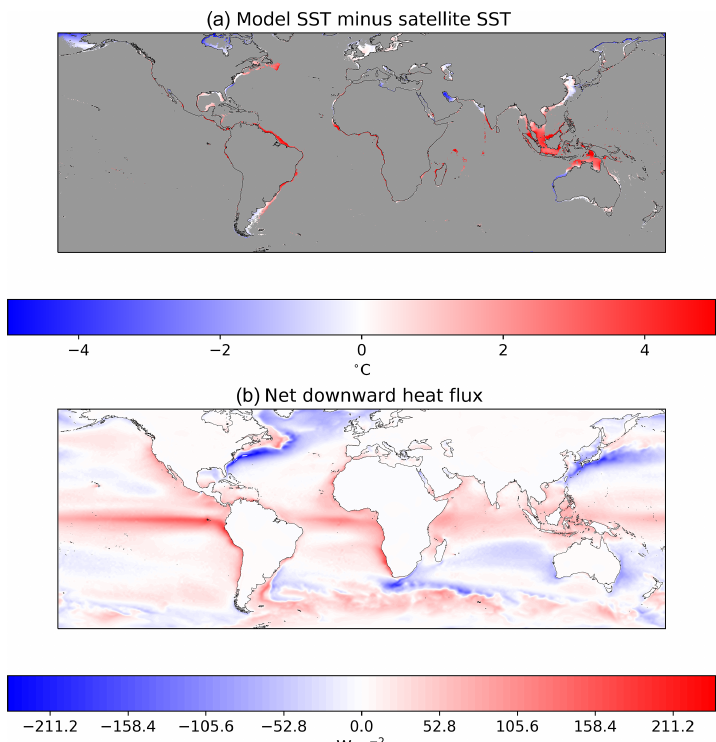
Figure 4. (a) Model SST simulation minus satellite SST data averaged between 1 January 2006 and 31 December 2016. White indicates that the model is displaying no surface temperature bias, red indicates the model displays a warm bias, and blue indicates the model displays a cool bias. The model was forced with atmospheric data from ERA5 (Hersbach et al., 2019). (b) Net surface downward heat flux calculated from the ECMWF ERA5 reanalysis (Hersbach et al., 2019). Where this is positive, there is a net heat flux into the ocean. So, assuming that system is approximately at steady state, heat is advected out of these areas. Where the net downward heat flux is negative there is advection of heat into this region. S2P3-R V2.0 does not account for lateral advection, so one would anticipate that the model will display a warm bias in regions where heat is typically advected from (i.e. tropics) and cool biases where heat is advected to (i.e. high latitudes).